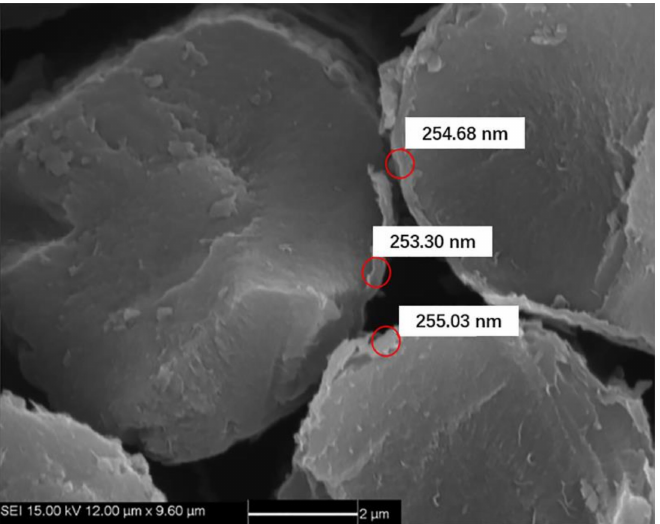
Figure 1. Scanning electron microscope (SEM) micrograph of pyrolytic carbon interface layer on carbon fiber.